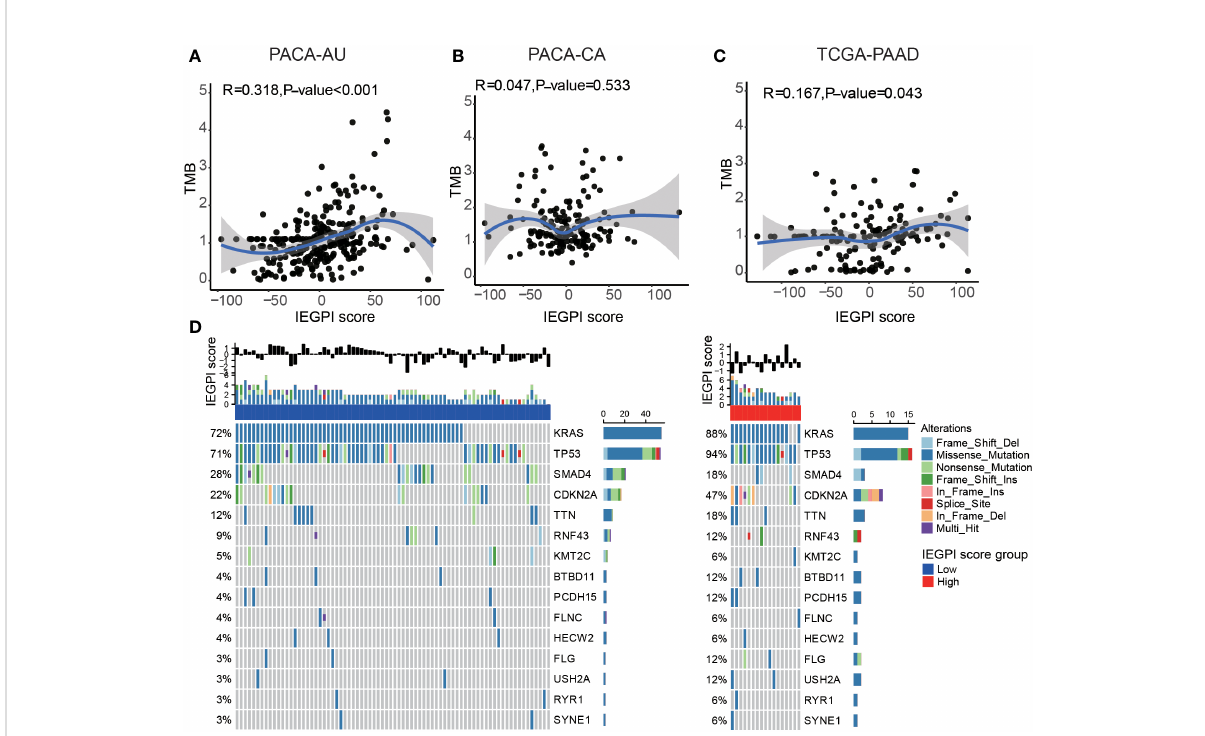
FIGURE 4 Relationship between the mutation genes and IEGPI score. (A – C) Relationship between the IEGPI score and TMB score in three public datasets; (D) the landscape of top 15-gene mutations in different IEGPI